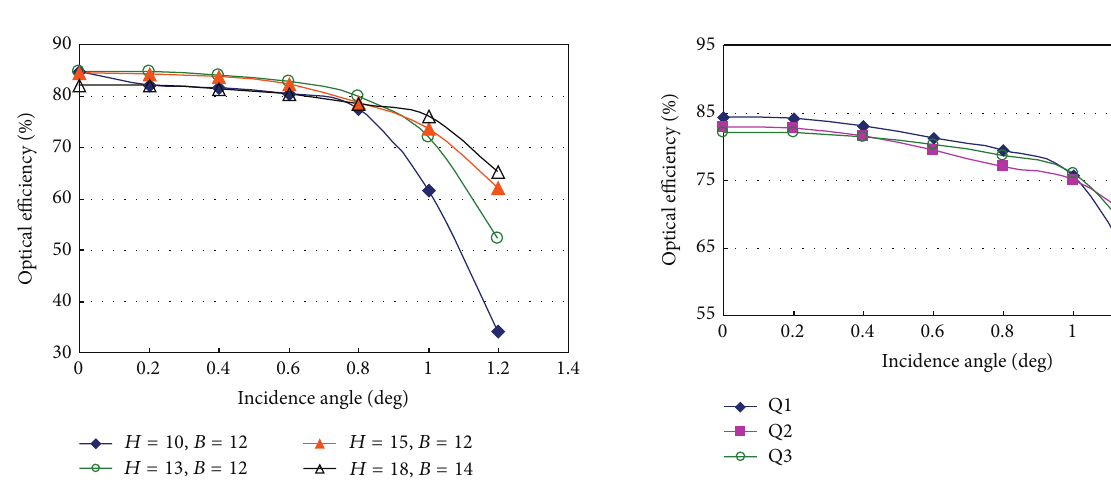
Figure 8: Optical efficiency with 3 optimal SOEs of Phase I under various incidence